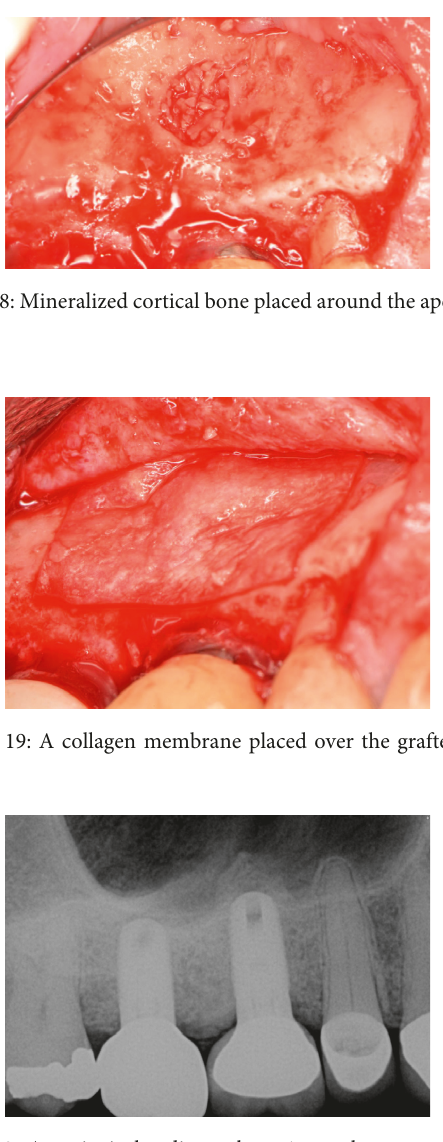
Figure 20: A periapical radiograph at 6 months postoperatively demonstrated an increased density around the implant apex.